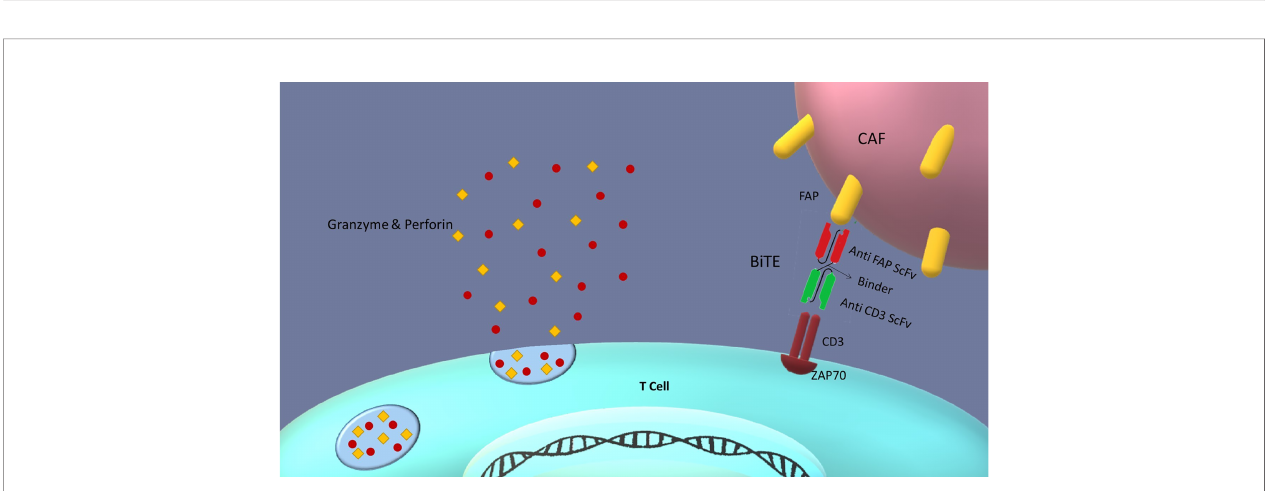
FIGURE 5 | BiTEs role in the tumor microenvironment: Bispeci fi c T cell engagers (BiTEs) are fusion proteins consisting of two ScFvs linked together. One of the ScFvs binds to the T cells CD3 marker and the other to an antigen on the targeted cell. Thus, they can establish a link between T cells and target cells in an MHC- independent manner. In our design, CAR T cells secrete BiTEs against FAP antigen on cancer-associated fi broblasts (CAFs); therefore, CAR T cells can be redirected against tumor-suppressive microenvironment by killing cancer-associated fi broblasts. This redirection could be favorable for cancer therapy because of reducing tumor progression and metastasis, and